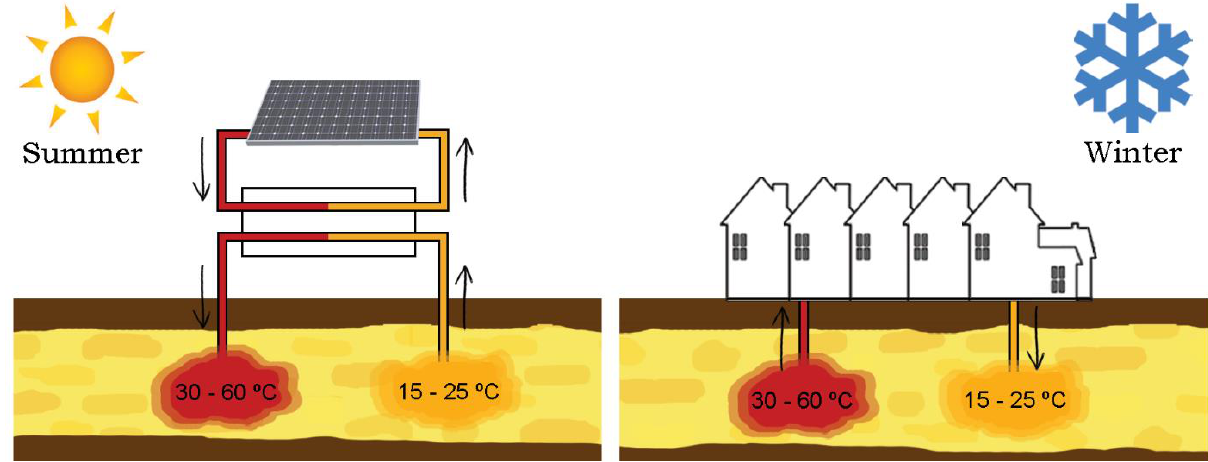
Figure 1. High temperature aquifer thermal energy storage (HT-ATES) system working principle. ( Left ) In summer, available heat from solar + heat pump (PtH) is stored in the HT-ATES system. ( Right ) In CHT-ATES hot wells.